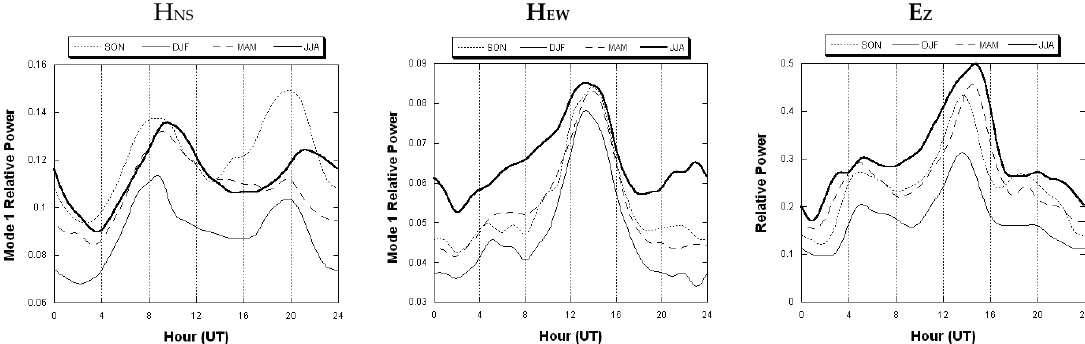
Figure 6. The four-year mean diurnal and seasonal variations of the SR power for the first mode—individual electromagnetic components of the SR field [56]. SON = September, October, and November; DJF = December, January, and February; MAM = March, April, and May; JJA = June, July, and August.